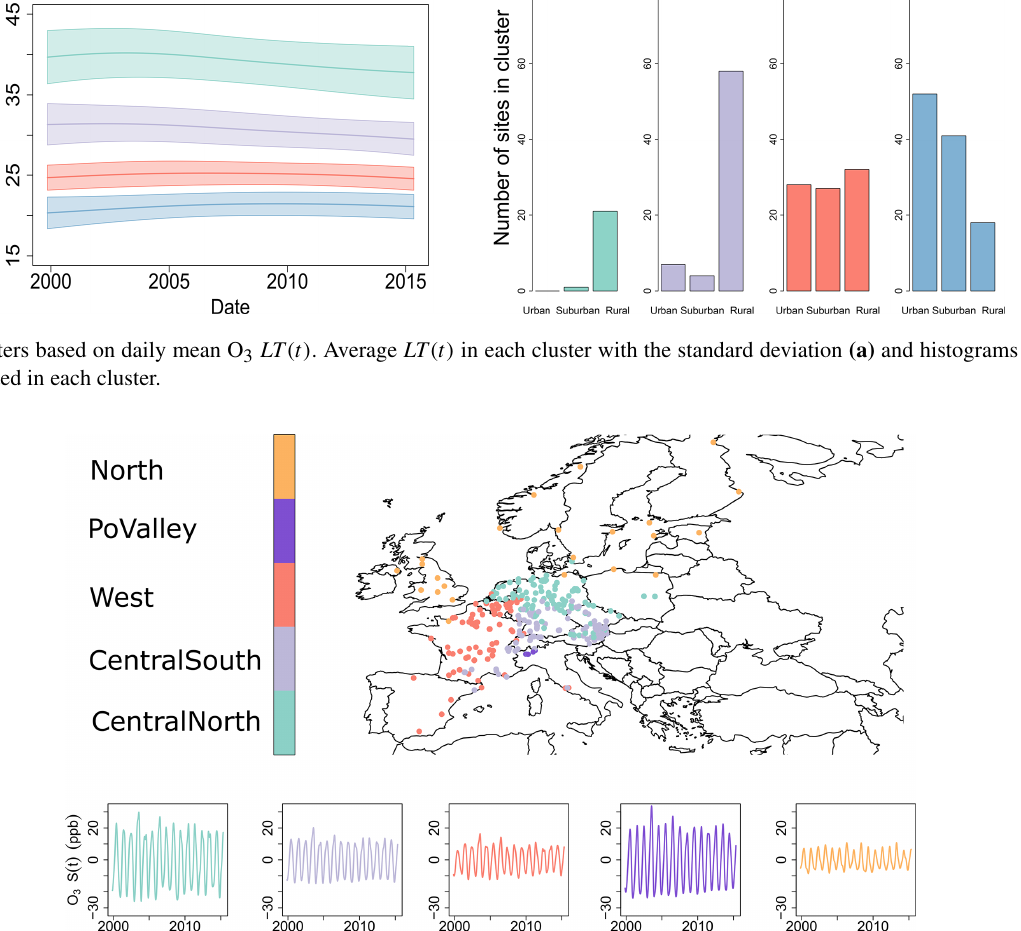
by spatial interpolation, leading to a larger and regular geo- graphical coverage compared to the available